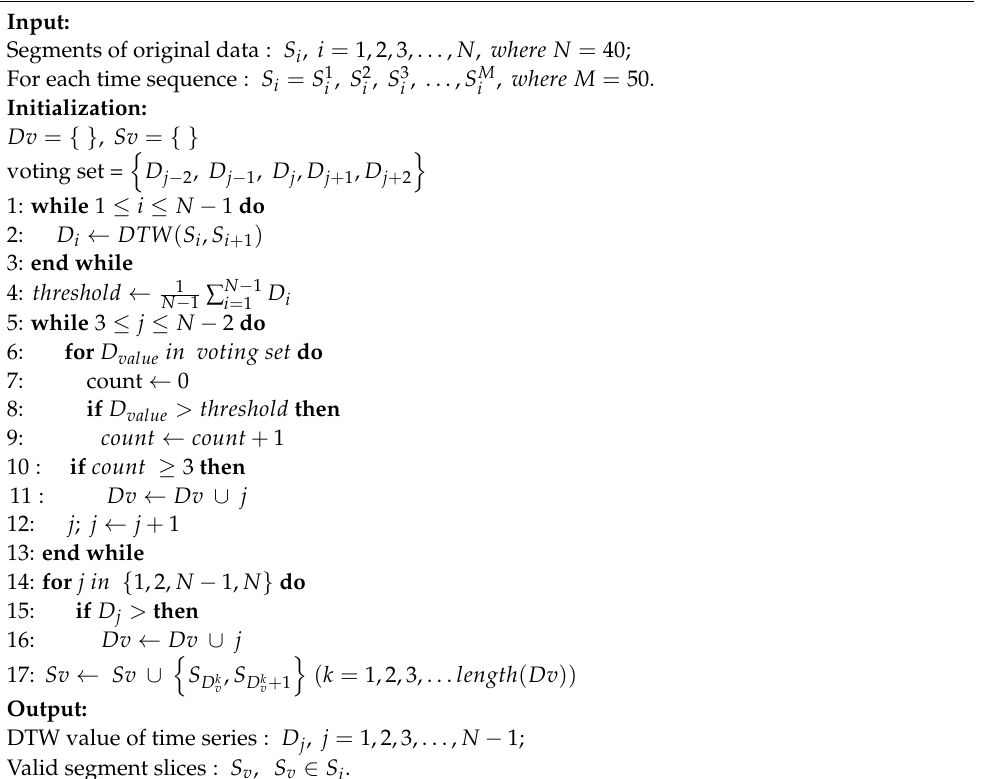
Algorithm 1: Voting-Based DTW (VB-DTW) valid segment extraction